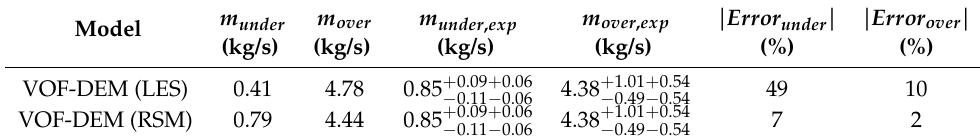
Table 5. VOF-DEM water mass flow rate model